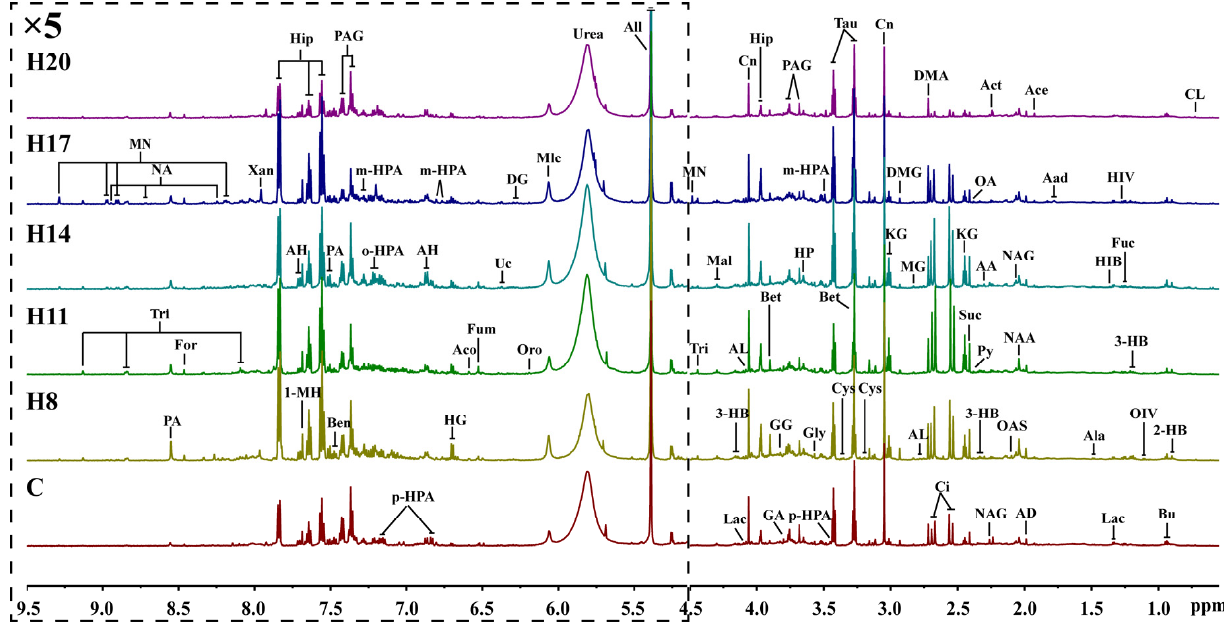
Figure 4. Representative 600 MHz 1 H NMR spectra ( δ 0.5–5.1 and δ 5.1–9.5) of intrauterine